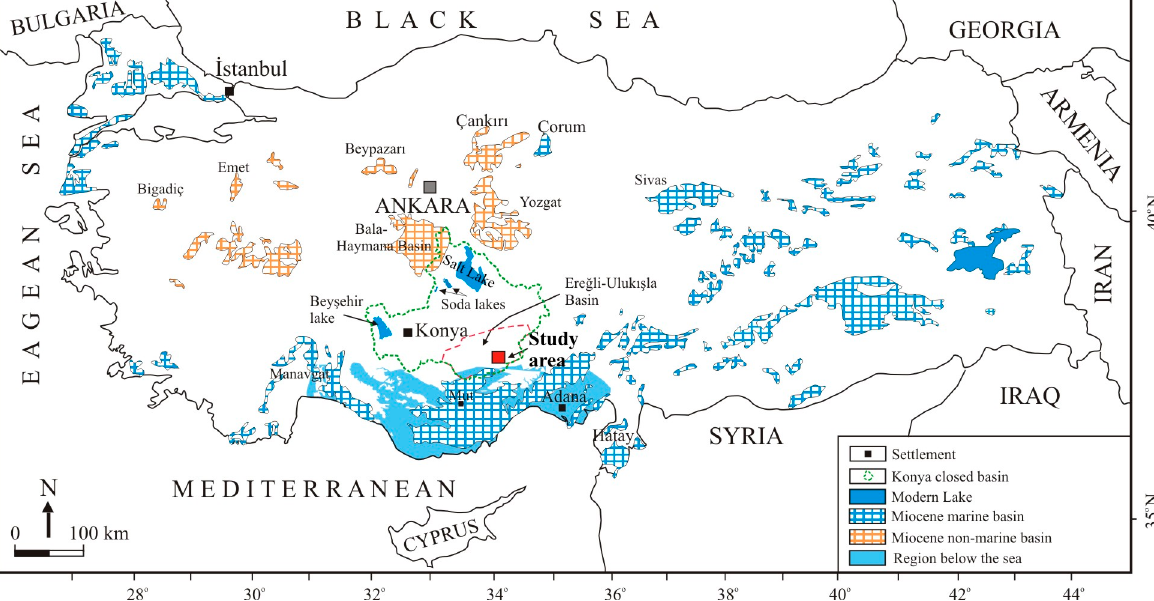
Figure 1. Study area on the Paleogeographic map (before 8 Ma). Pale blue areas indicate regions of modern topography that were below sea level prior to 7 to 8 Ma (modified from [26] and Miocene marine and non-marine basins in Türkiye are simplified after MTA [27].